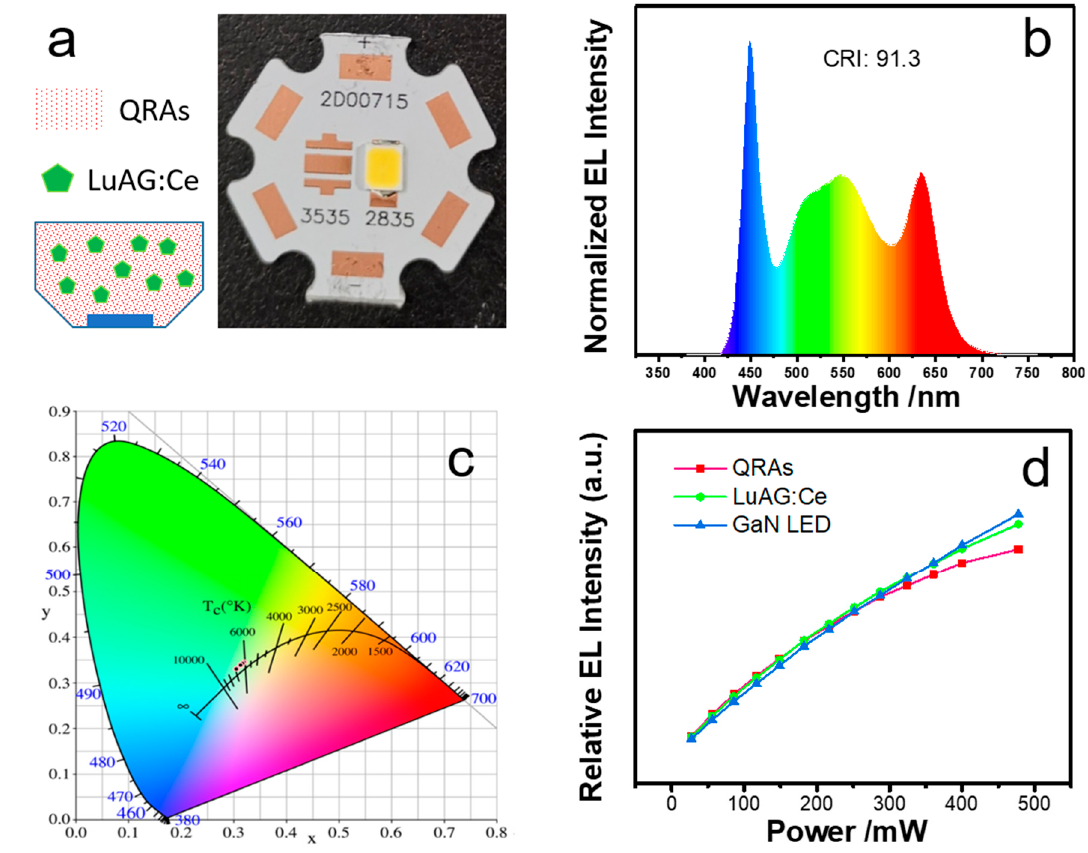
Figure 8. ( a ) The packaging structure and physical diagram of the QRA-based WLED package; ( b ) EL spectrum of the WLEDs; ( c ) color coordinates of the WLED at different driving powers; ( d ) relative light intensities of different light sources in WLED driven from 27 to 450 mW.